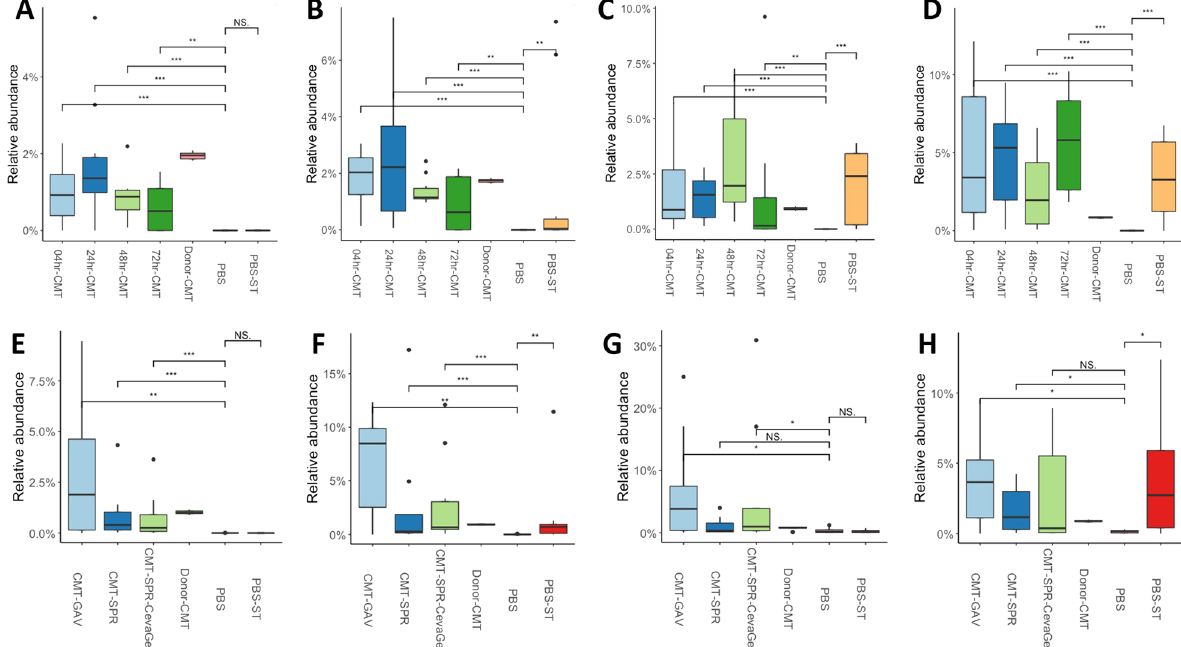
Fig. 8 Faecalibacterium prausnitzii abundance is higher in CMT chicks than PBS controls both pre-infection and during the early stage of infections. The Relative abundance of F. prausnitzii in the chicken gut microbiome of broiler chickens in CMT groups vs PBS controls from Experiment A ( A – D ) and Experiment B ( E – H ). At 7-dph and prior to ST4/74 infection the relative abundance of F.prausnitzii is significantly higher in the CMT groups compared to the PBS consistent for both experiments ( A and E ). Following infection, the relative abundance of F. prausnitzii increases in PBS groups that were challenged with ST4/74 but not in PBS unchallenged groups ( B – D , F and H ). This is not apparent at 7-dpi during the route experiment where there is no significant difference in the relative abundance of F. prausnitzii between the PBS groups or between the spray CMT group (G). * P < 0.05, ** P < 0.01, *** P < 0.001, **** P < 0.0001 as determined by Wilcoxon non-parametric